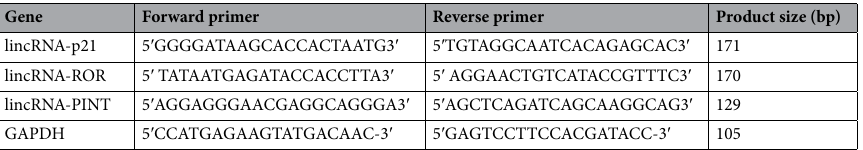
Table 1. Primers used in